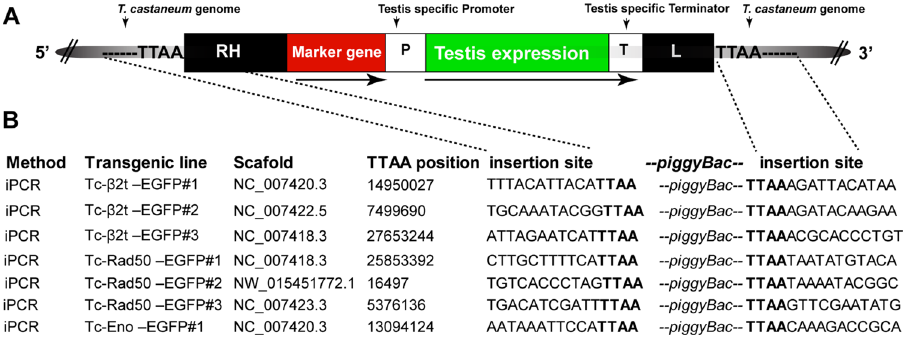
Figure 11. Inverse PCR strategies to isolate and sequence the piggyBac vector and insertion sites in different transgenic lines. ( A ) Schematic diagram (not to scale) of the piggBac vector insertion in the T. castaneum genome. The vector contained the marker cassette as a visual marker and piggyBac inverted repeats (RH and L) for transposase mediated integration in T. castaneum genome. P putative promoter region, T putative terminator region. Duplicated TTAA flanked the piggyBac elements in the host genome. ( B ) Below are shown the TTAA position in the T. castaneum genome where the transgenes were inserted and the flanked piggyBac transgenes insertion site sequences from the transgenic